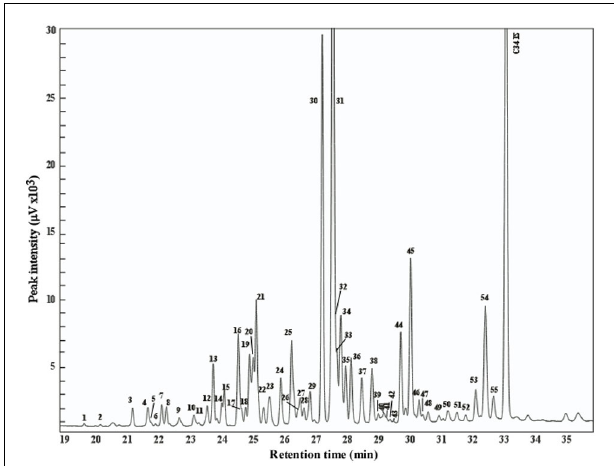
FIGURE 3 | Chromatogram of the PPG secretion of a C. niger worker from Rishon Leziyyon site. Peaks identity is as follows: 1, Tetracosane; 2, 12-methyltetracosane; 3, pentacosane; 4, 11- + 13-methylpentacosane; 5, 7-methylpentacosane; 6, 5-methylpentacosane;